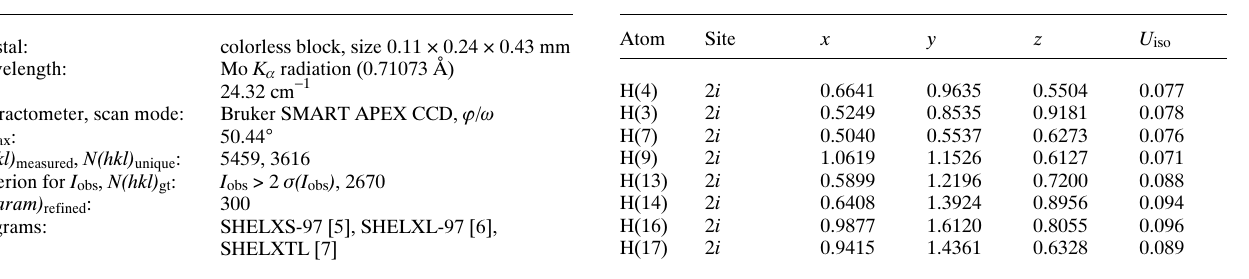
Table 2. Atomic coordinates and displacement parameters (in Å 2 ) . Table 1. Data collection and